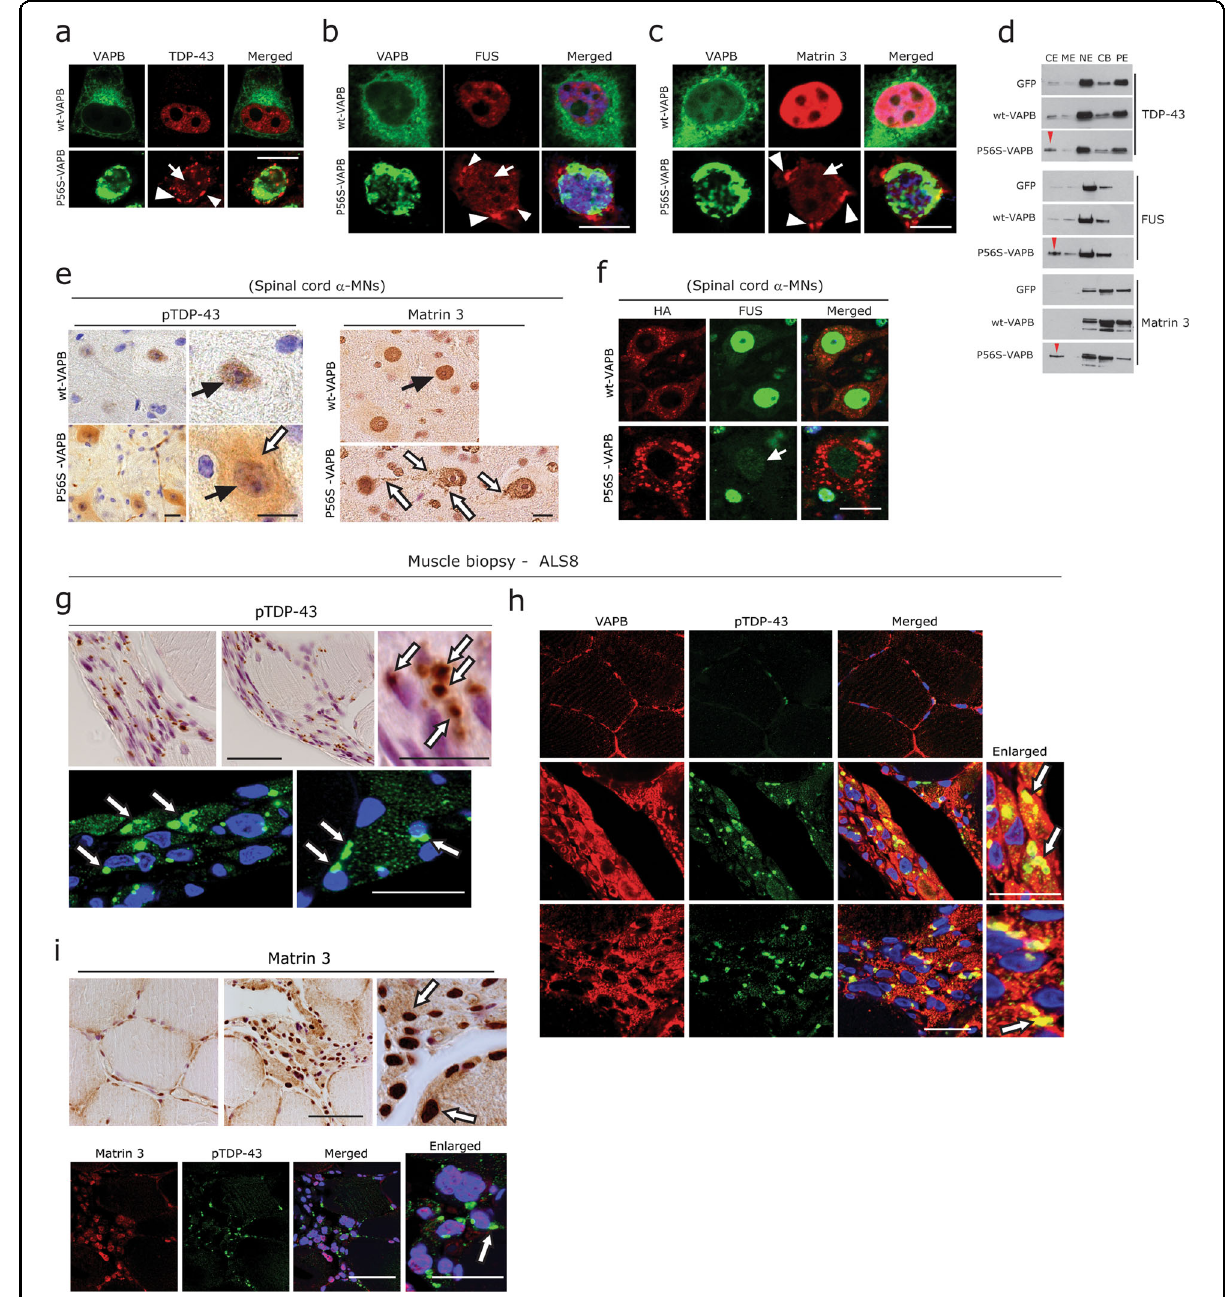
Fig. 5 P56S-VAPB and altered distribution of other fALS-associated RBP. a – c Co-labelling of HeLa cells expressing wt-VAPB and P56S-VAPB with antibodies against TDP43 ( a ) with FUS ( b ) and with Matrin 3 ( c ). Note that the cytoplasmic aggregation (arrowheads) and reduced nuclear immunoreactivity (arrows) of these RBPs in P56S-VAPB expressing cells. Scale bar: 10µm. d Immunoblot analysis of the subcellular fractions obtained from HeLa cell expressing wt-VAPB and P56S-VAPB. Note the increased levels of TDP-43, FUS and of Matrin 3 (red arrowheads) in cytoplasmic extract (CE). ME membrane extract, NE nuclear extract, CB chromatin bound, PE cytoskeleton. e DAB immunohistochemistry using antibodies against pTDP-43 and Matrin 3, showing altered nuclear immunoreactivity (black arrows) and diffuse albeit increased cytoplasmic immunoreactivity (white arrows) in lumbar spinal cord α -MNs of P56S-VAPB tg mice. Scale bars: 15µm. f Double immuno fl uorescence labelling for HA and for FUS antibodies showing reduced labelling of FUS (arrow) in lumbar spinal cord α -MNs of P56S-VAPB tg mice. Scale bars: 15µm. g Prominent and globular pTDP-43 immunoreactivity (white arrows- upper panel; DAB, lower panel; immuno fl uorescence) of grouped angular or fl attened, atrophic, denervated muscle fi bres in the ALS8 biopsy. Scale bars: 80µm. h Co-localisation of globular and aggregated pTDP43 with VAPB aggregates (white arrows) in the same biopsy. Scale bars: 60µm. i DAB immunohistochemistry of Matrin 3, showing increased immunoreactivity of the myonuclei (arrows) and mildly diffuse saromeric accumulations. Note the basal myonuclei immunoreactivity of Matrin 3 in non-atrophic normal-sized fi bres (left panel). Co-immunolabelling (lower panel) with pTDP-43 antibody showed no co-localisation between Matrin 3 accumulations and pTDP-43 aggregates. Scale bars: 80µm. Of fi cial journal of the Cell Death Differentiation